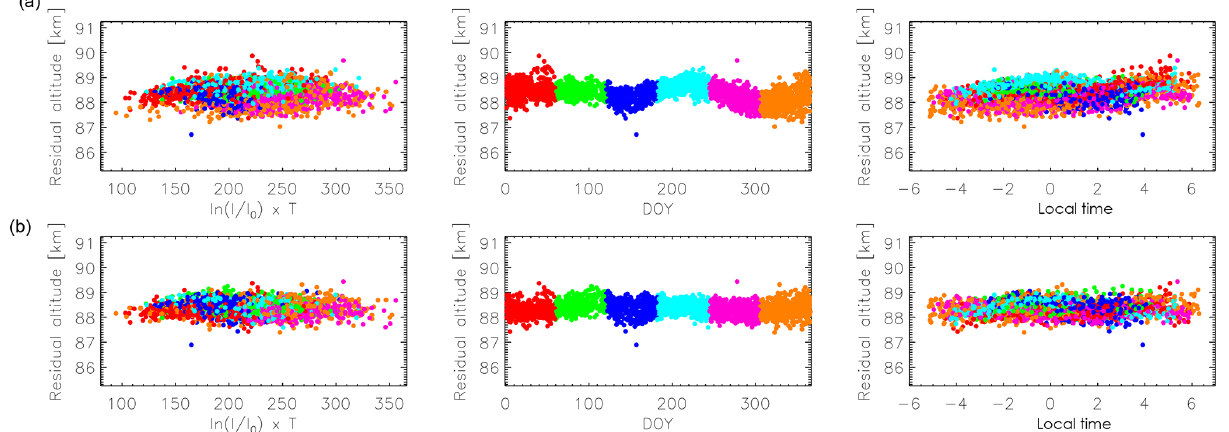
Figure 4. SABER OH layer altitude residuals (plus mean altitude) after subtracting only the fitted T oh × ln I oh and T oh × ln T oh terms (a) and all the fitted terms (b) of Eq. (3). Color code as in Fig.